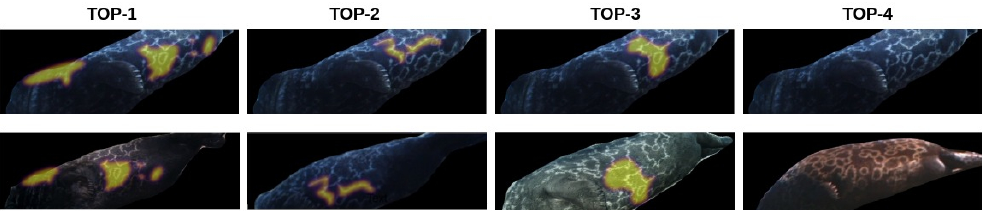
Figure 9. TOP-4 examples for the Hotspotter algorithm. First line: query image (phs10), Second line: four best matches in decreasing order of similarity from left to right. Matched hotspots are highlighted in yellow. TOP-1–TOP-3 matches are correct. TOP-4 is